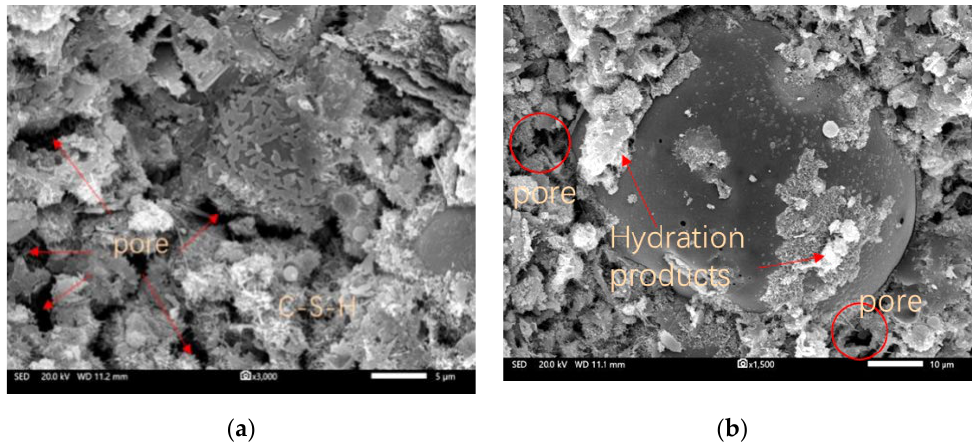
Figure 10. SEM pictures of FA25-P under HD condition, ( a ) Microstructure and ( b ) FA particles in paste.